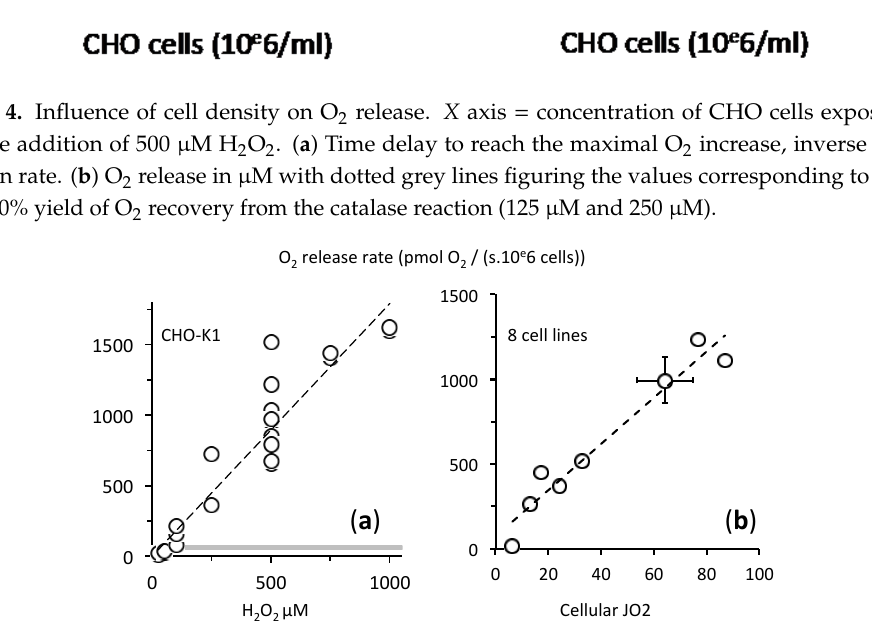
Figure 5. High initial rates of O 2 reflect the catalytic efficacy of catalase reaction. Y axis = initial O 2 release rate determined over 10 to 40 s after H 2 O 2 injection; ( a ) X axis = H 2 O 2 final concentration after injection; CHO-K1 cells suspension were in the range 1.5 to 2.2 × 10 6 cells/mL; thick grey line = CHO-K1 cellular oxygen consumption ( ≈ 60 pmol O 2 /(second × 10 6 cells) given for comparison’s sake; dotted line = linear fitting, which suggested the absence of saturation up to 1 mM H 2 O 2 . ( b ) The catalase initial rate after 500 µM H2O2 injection was determined with eight different cell lines. X axis = endogenous cellular oxygen consumption rate (respiration) before the single 500 µM H 2 O 2 addition. The different cell types are listed according to increasing X values: human lymphoblasts (HPB-All, Jurkat, DND, Molt4), human immortalized skin fibroblast, CHO-K1 ± SD ( n = 21 more data than in ( a ), cell density from 0.35 to 2 × 10 6 cells/mL), osteosarcoma 143B, and human neuroblastoma (SH-SY5Y). The dotted line represents linear fitting with values Y = 14 x + 75 with R 2 = 0.94.